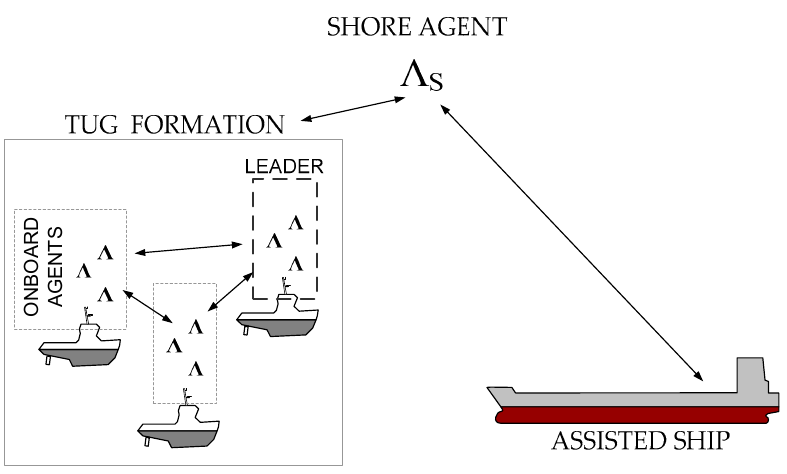
Figure 2. Structure of the proposed agent system.